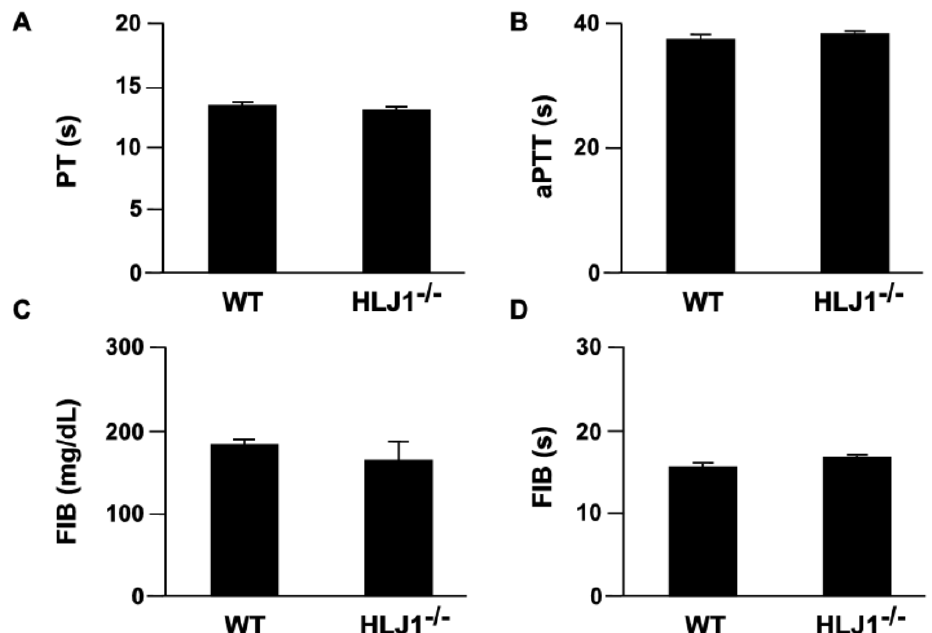
Figure 3. The parameters of plasma coagulation in WT and HLJ1 -/- mice. ( A , B ) The plasma of mice was isolated, and prothrombin time (PT) and activated partial thromboplastin time (aPTT) were evaluated. ( C , D ) The plasma level of fibrinogen (FIB) and time of fibrin clot formation (s) were assessed. Data are the mean ± SEM from 9 mice.